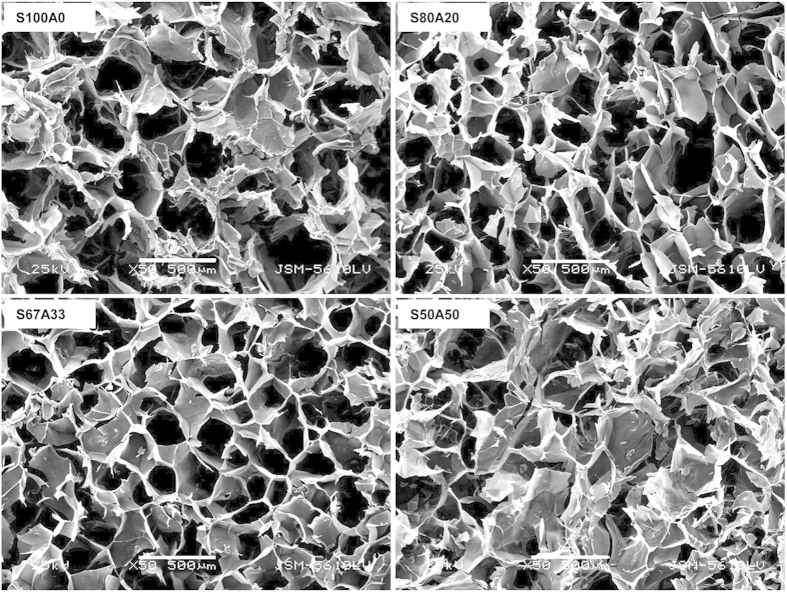
The porous microstructure of the sericin-alginate IPN hydrogels.The micrographs obtained using SEM show the random regions in the lyophilized samples of the pure sericin hydrogel (S100A0) and the IPN hydrogels (S80A20, S67A33 and S50A50) frozen at −80oC. Scale bars, 500 μm.